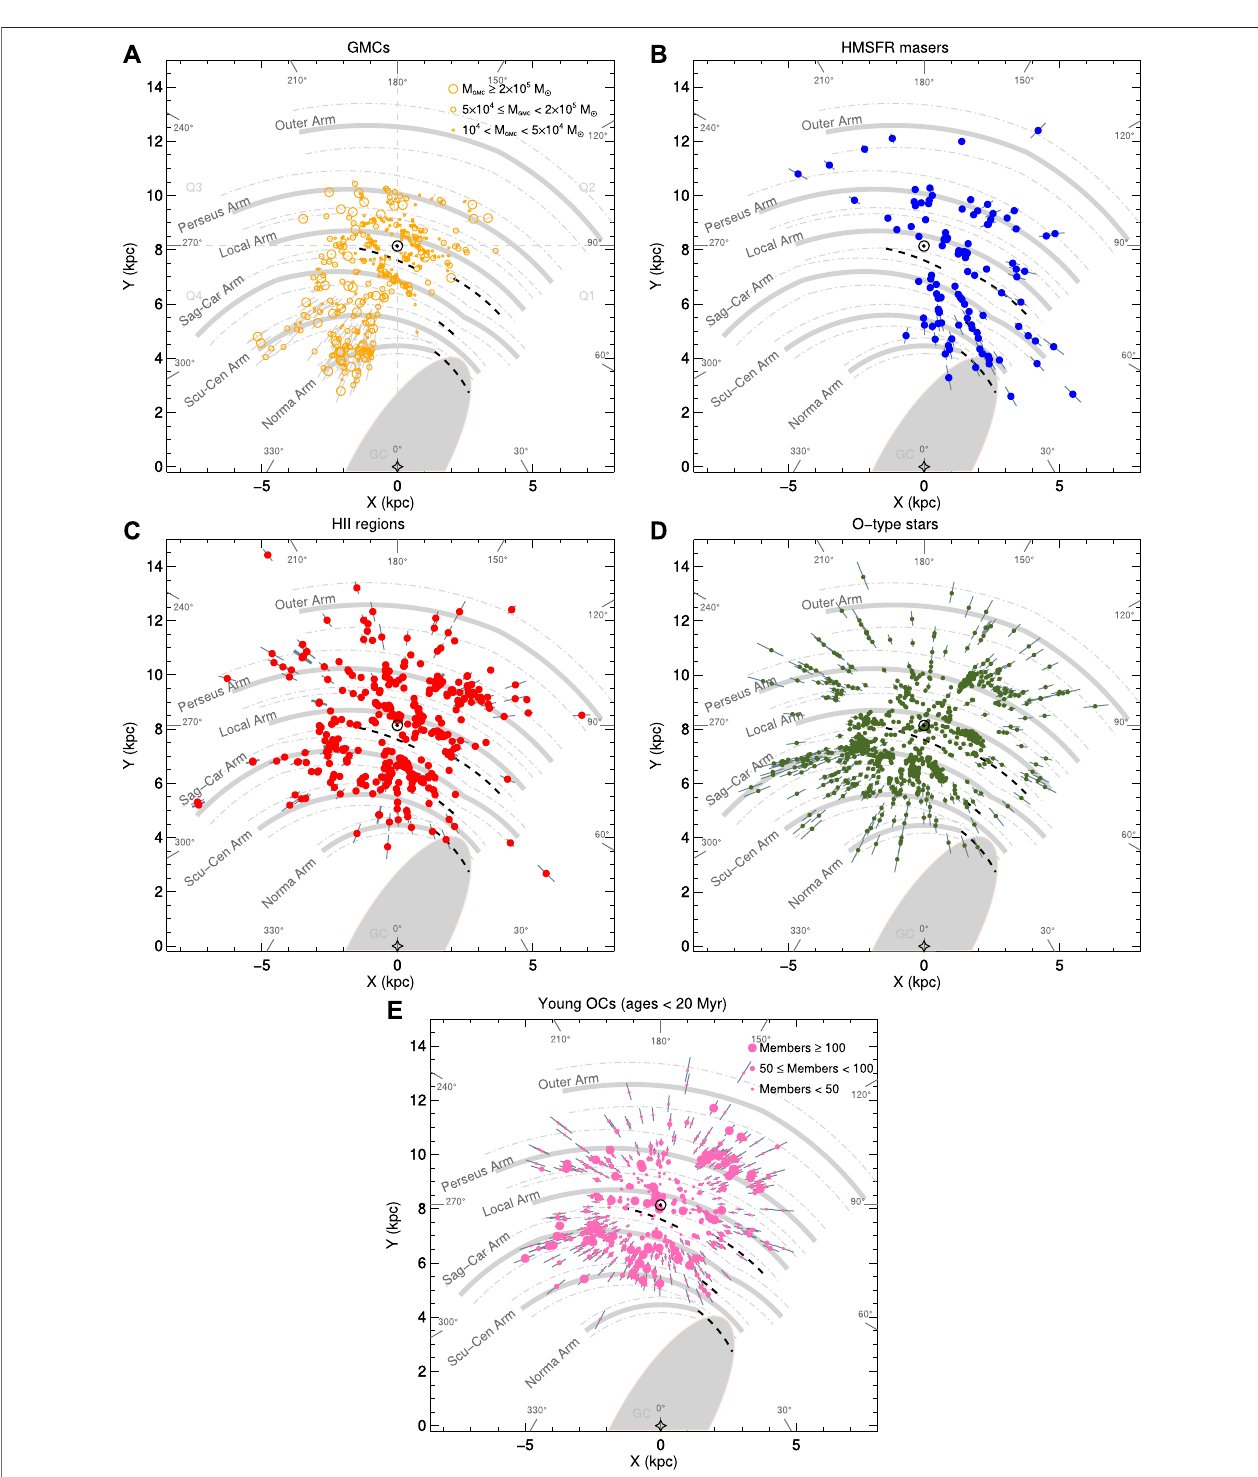
FIGURE1| Distributionsof (A) GMCs, (B) HMSFRmasers, (C) HIIregions, (D) O-typestars,and (E) youngOCsinthesolarneighborhood.Alloftheplottedobjects have distance uncertainties better than 15% and < 0.5 kpc as determined by the trigonometric or photometric method. The symbol sizes of GMCs are proportional to their masses. For HMSFR masers, HII regions, and O-type stars, an equal size of the dots is adopted. The symbol sizes of young OCs are proportional to the number of cluster member stars. The position uncertainty for each data point is shown by an underlying gray line segment. The thick gray curved lines indicate the best fi tted spiral arm modelgiven byReidet al.(2019),thedotted lines denotethearm widths enclosing 90%oftheHMSFR masers. Theblack dashed lines indicate thefour spurs orspur-likestructuresproposedinliterature(see Section3.3 ).Ineachplot,thesegmentsofspiralarmsarelabelled;theSunisat(0.0,8.15)kpc(Reidetal.,2019),while the Galactic center is at (0.0, 0.0) kpc; and the Galactic long bar is indicated by a shaded ellipse (Wegg et al., 2015).